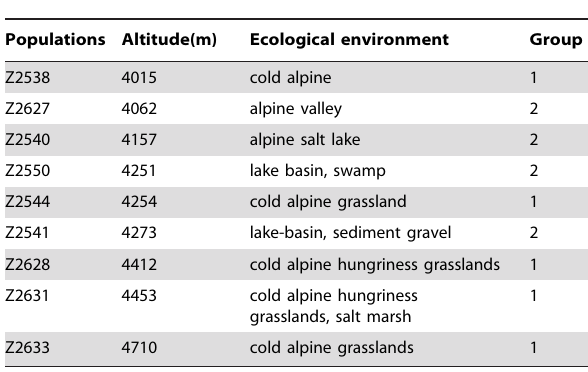
Populations Altitude(m) Ecological